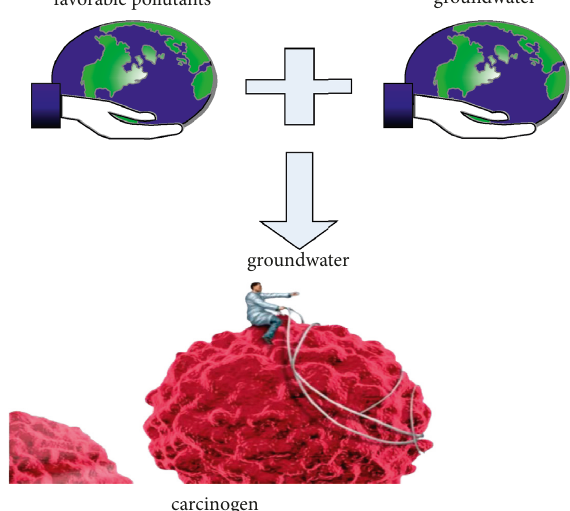
Figure 2: Harm of organic pollutants to human